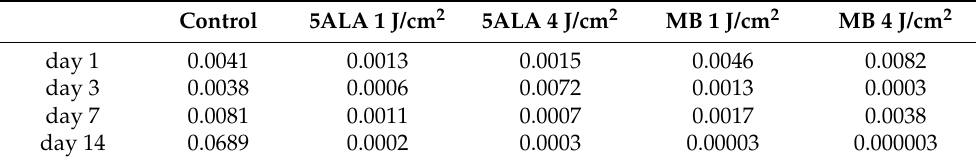
Table 2. The p -values for all groups in comparison with healthy skin on all observation days (n =